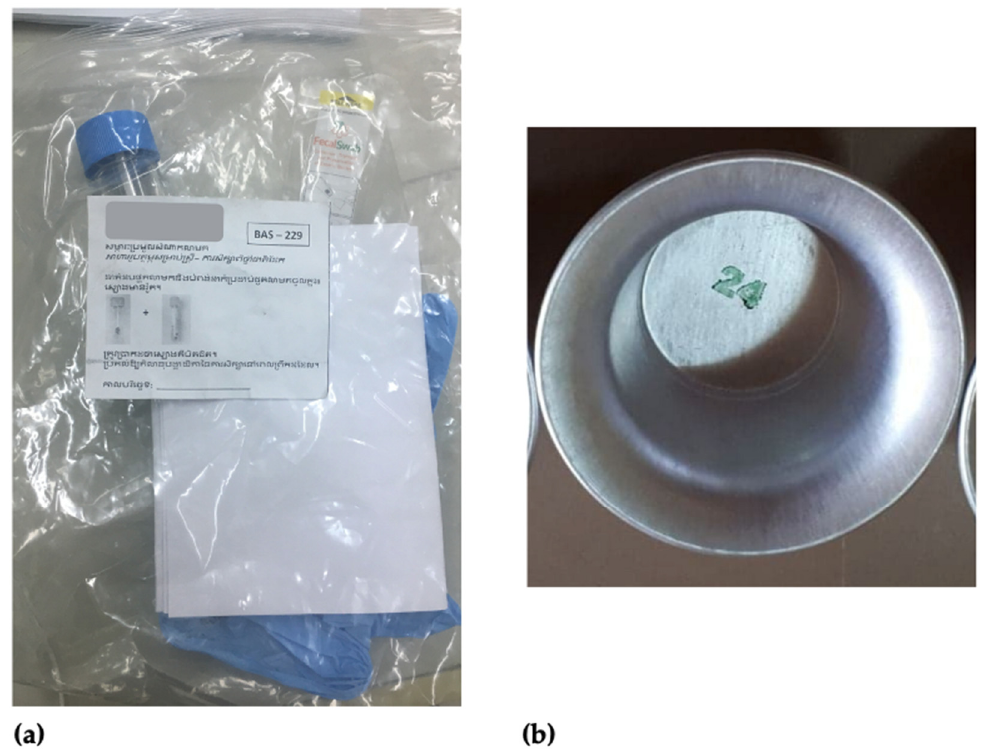
Figure 1. Stool Collection Kit: ( a ) Resealable participant labelled bag, infographic, gloves, 30 mL clear polystyrene stool collection container; ( b ) Metal collection pot.